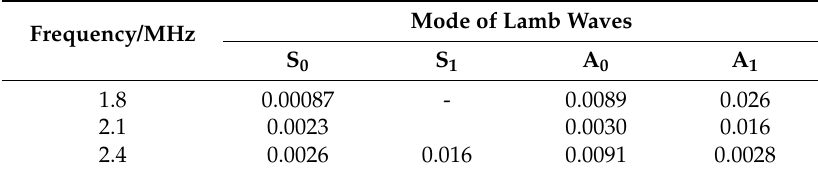
Table 7. Group velocities of different modes of Lamb waves.